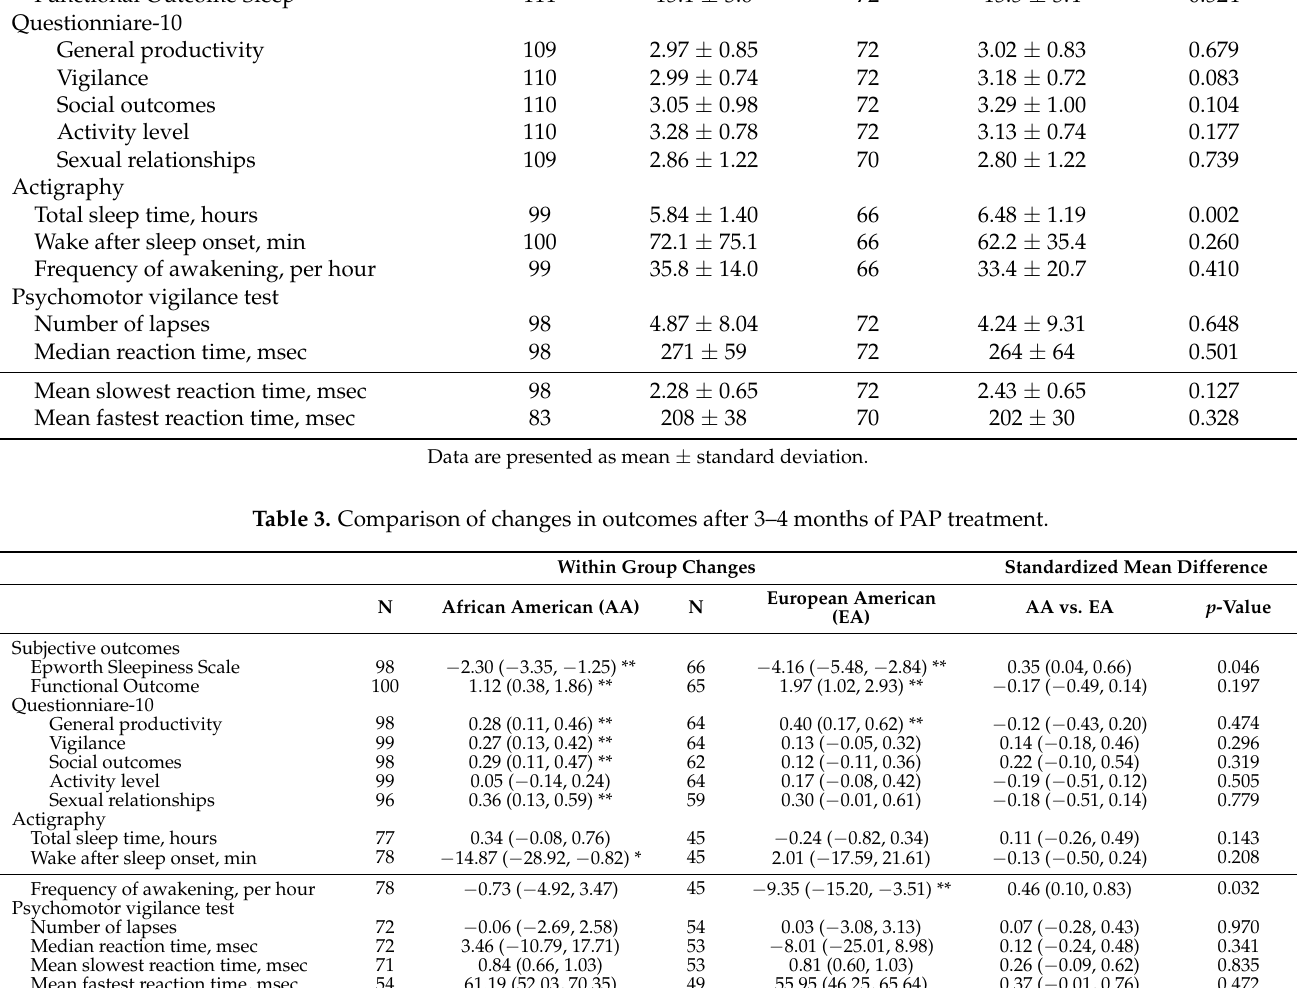
Between-group comparisons revealed that the AA group had evidence of smaller reduc- tions in ESS score (mean change (95% CI] − 2.30 [ − 3.35, − 1.25] vs. − 4.16 [ − 5.48, − 2.84]) and frequency of awakenings (mean change (95% CI] − 0.73 [ − 4.92, 3.47] vs. − 9.35 [ − 15.20, − 3.51]) after PAP treatment compared to EA, adjusting for covariates, including PAP adherence and SES measured by SVI (Table 3). Compared to EA group, SMDs for changes in ESS was (SMD (95% CI) = 0.35 [0.04, 0.66]; p = 0.046) and frequency of awakenings (SMD (95% CI) = 0.46 [0.10, 0.83]; p = 0.032) after PAP treatment in AA